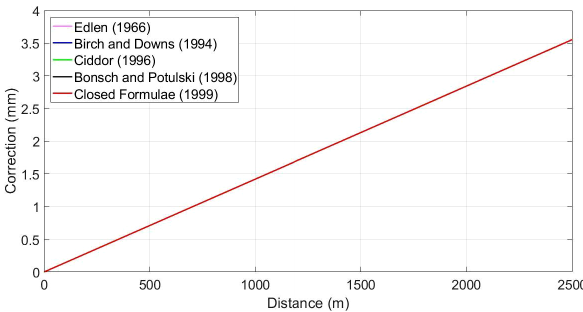
Figure 13. Correction vs. measured distance